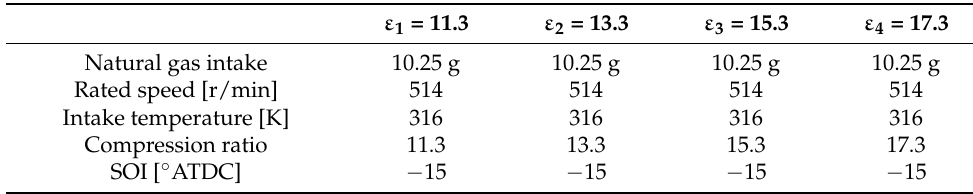
Table 6. The simulation parameters.